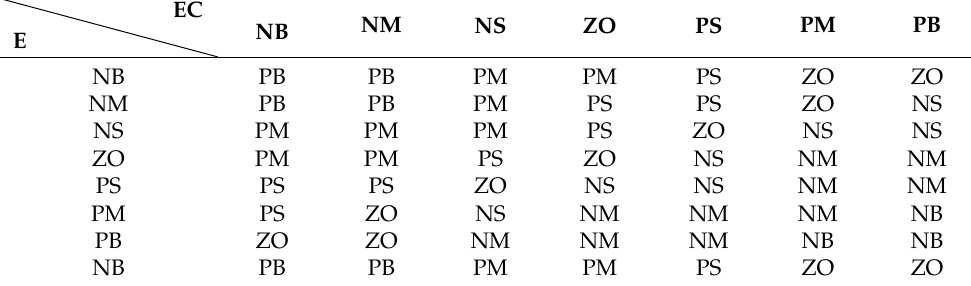
Table 1. Fuzzy rule of ∆ K p .